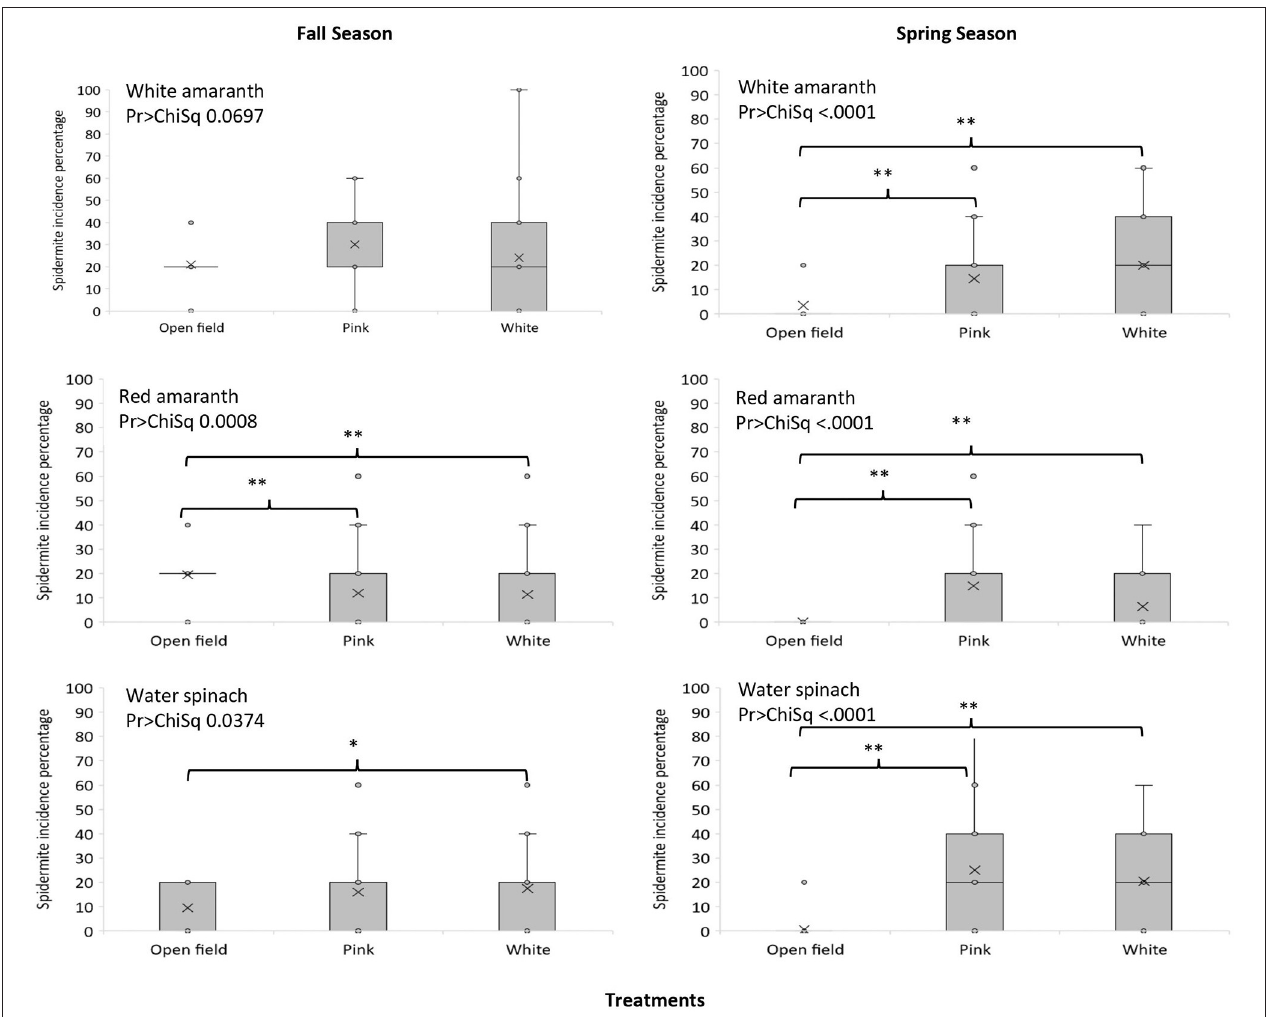
FIGURE 2 | Mean ( ± SD) incidence of spider mite ( Tetranychus spp.) on leafy vegetables grown under different production conditions. (A) White amaranth, (B) Red amaranth, (C) Water spinach. Means represent average of four replications in each treatment/season. *significant; **highly